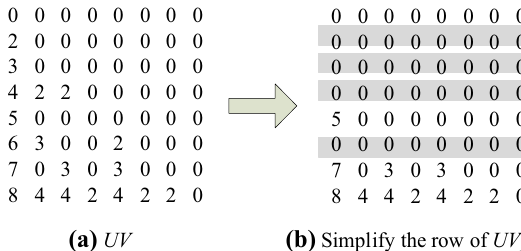
Fig. 4 Transformation of the judgment matrix of ABO/ Rh (D)-compatible blood